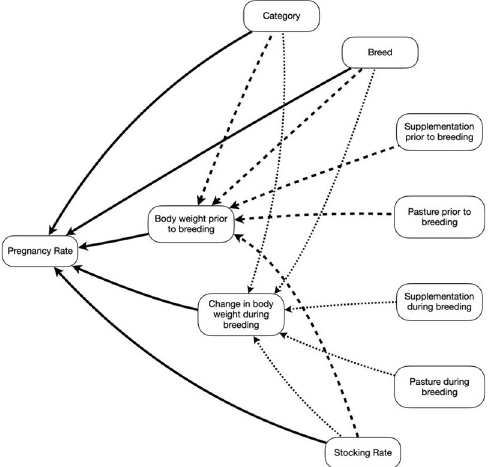
Fig 1. Schematic structure of the hypothesized determinants of pregnancy rate (PR). Full lines represent direct effects, dotted lines represent indirect effects through change in body weight during breeding, and dashed lines represent indirect effects through body weight prior to breeding.